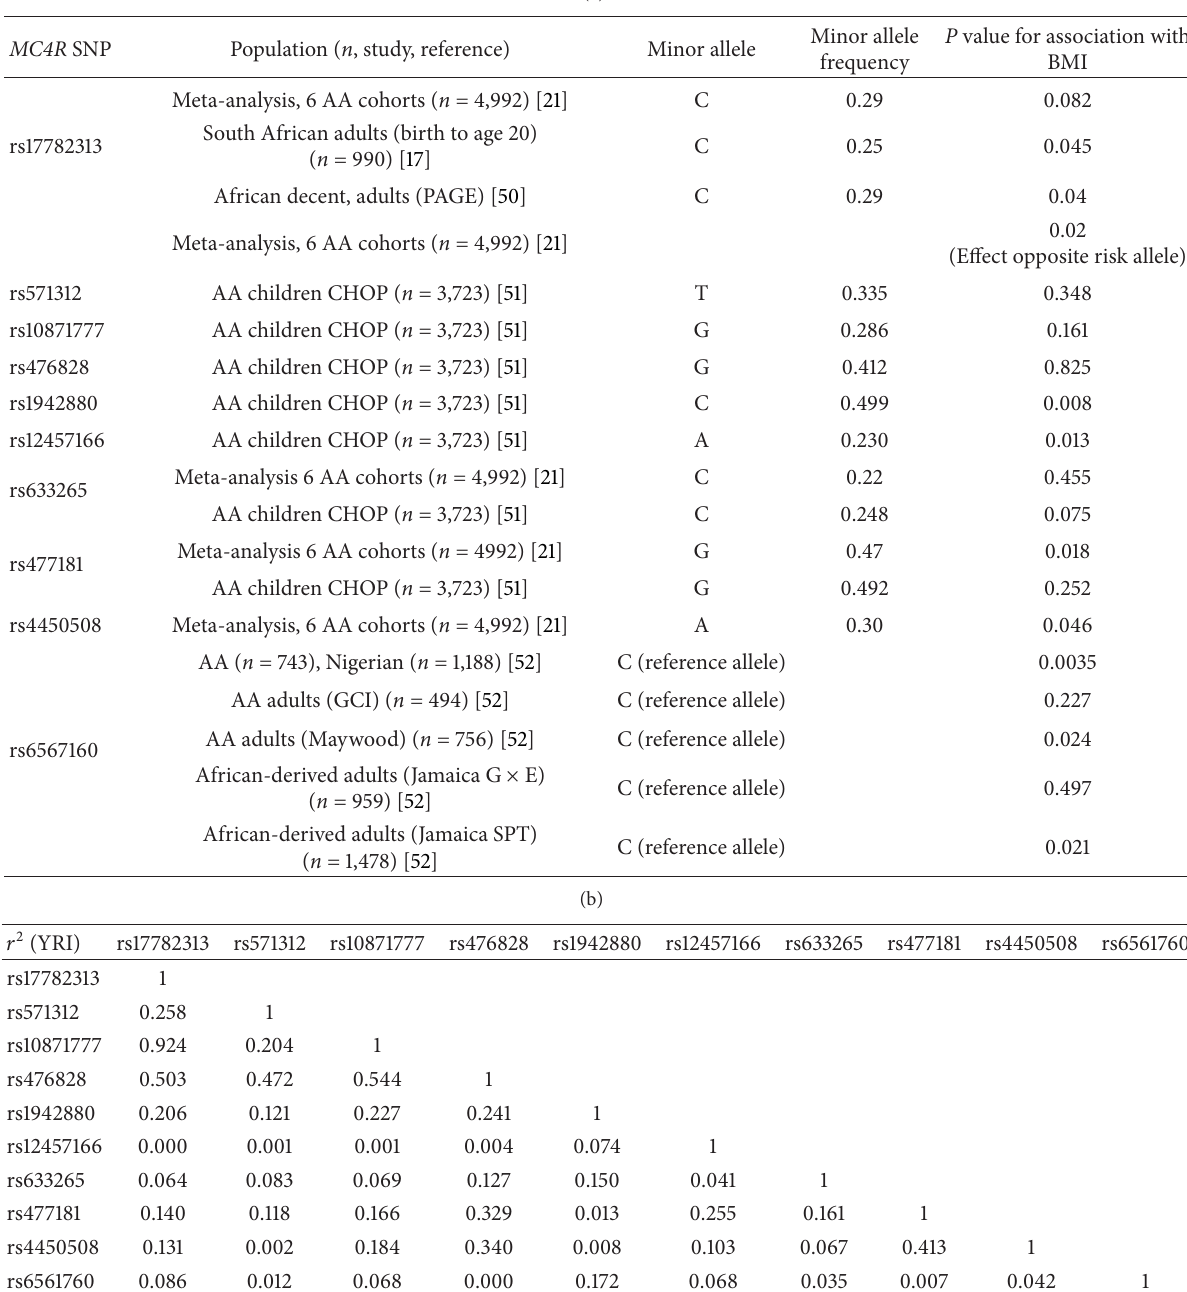
Table 2: (a) MC4R variation and BMI in populations of African ancestry. (b) Degree of linkage disequilibrium between MC4R SNPs in Table 2(a) in the YRI population